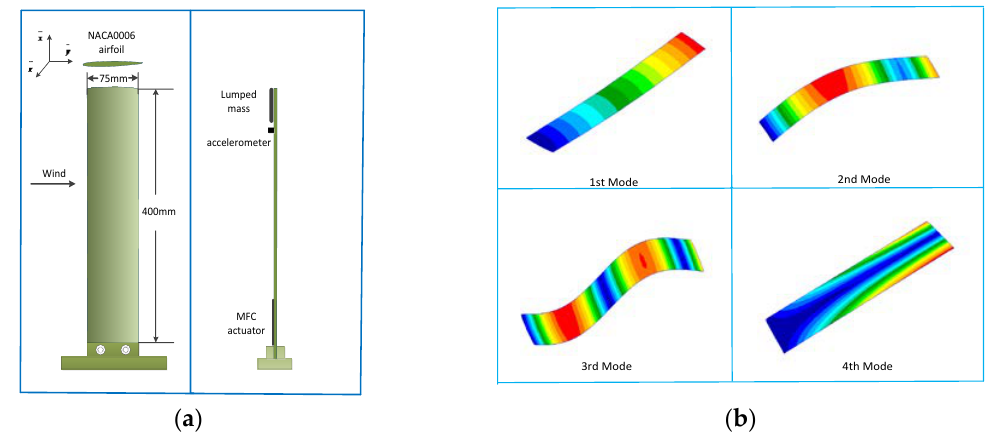
Figure 6. ( a ) Configuration of the flexible wing model; ( b ) mode shape of the flexible wing. Table 1. Comparison of numerical and experimental natural frequencies.